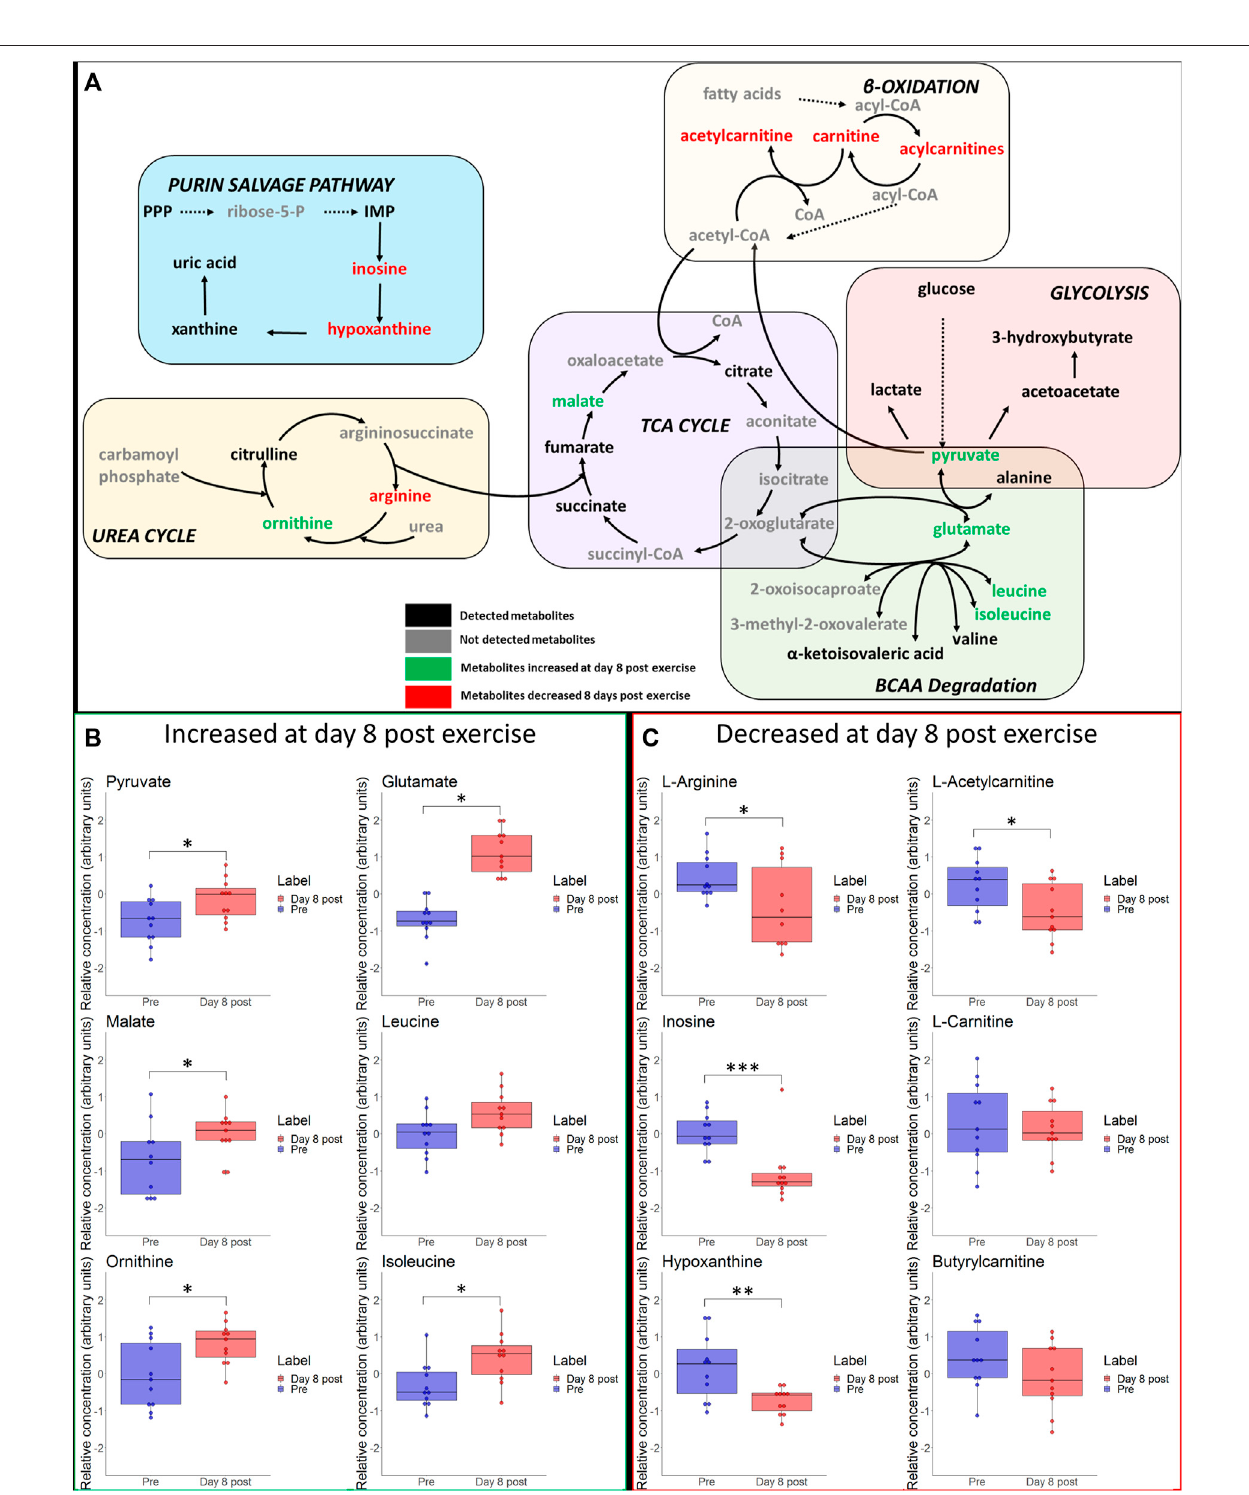
FIGURE 6 | (A) Schematic overview of most important metabolic pathways. Changes of selected metabolites related to glycolysis, betta-oxidation, TCA-cycle, urea cycle and branched-chain amino acids (BCAA) at day 8 after hypoxic exercise are shown. Metabolites coloured as green and red represent metabolites that were upregulatedanddownregulatedatday8afterexercise,respectively.Metabolitesmarkedasblackrepresentdetectedmetaboliteswhereasgreyindicatesnon-detected metabolites. * p ≤ 0.05, ** p ≤ 0.01, *** p ≤ 0.001 for signi fi cant increases (B) or decreases (C) in associated metabolites on day 8 post exercise.